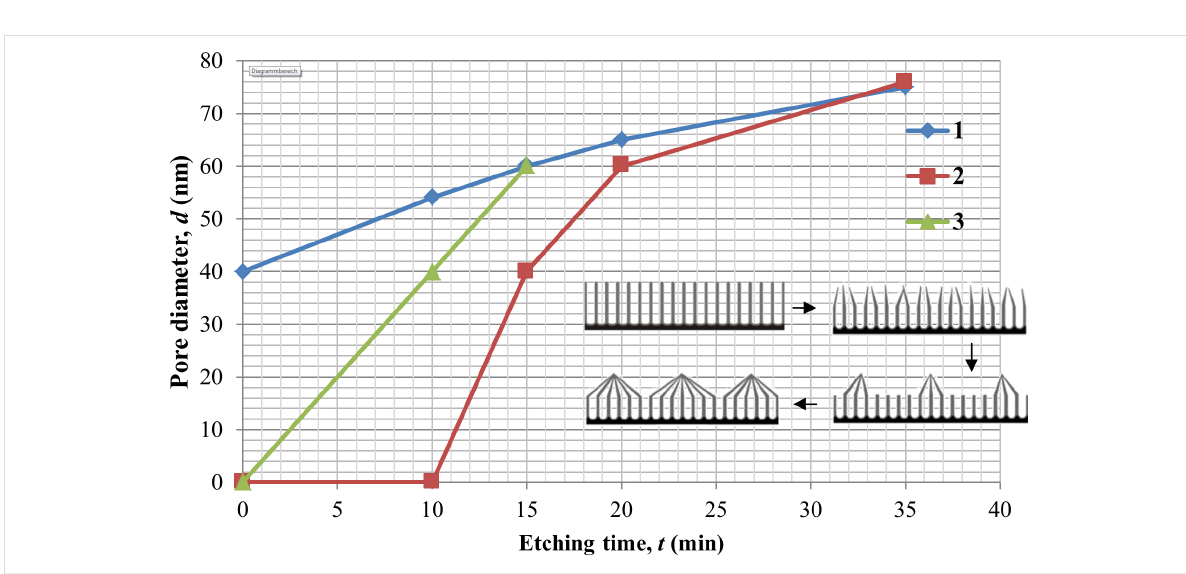
Figure 5: Pore diameter as a function of etching time of a barrier layer for the outer (1) and back (2, 3) surfaces of PAA, respectively: 3 – the back side was first treated in argon plasma for 40